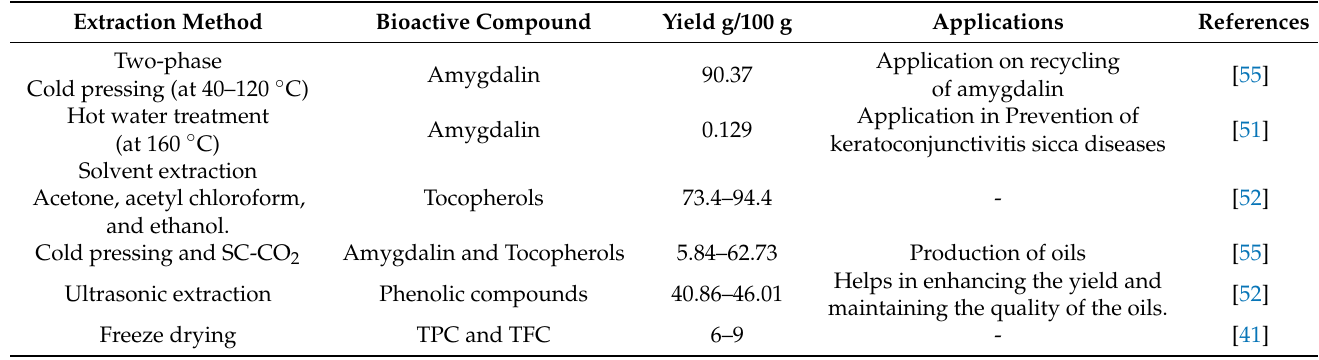
Table 2. Extraction & Application of Bioactive Compound of Apricot